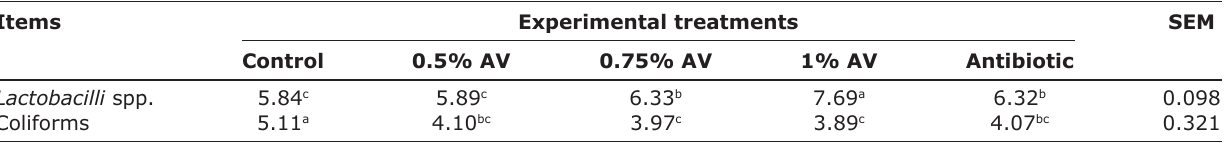
Table-5: Effect of experimental treatments on ileum bacteria populations of broiler chicks at 45 days of age. 1 Items Experimental treatments